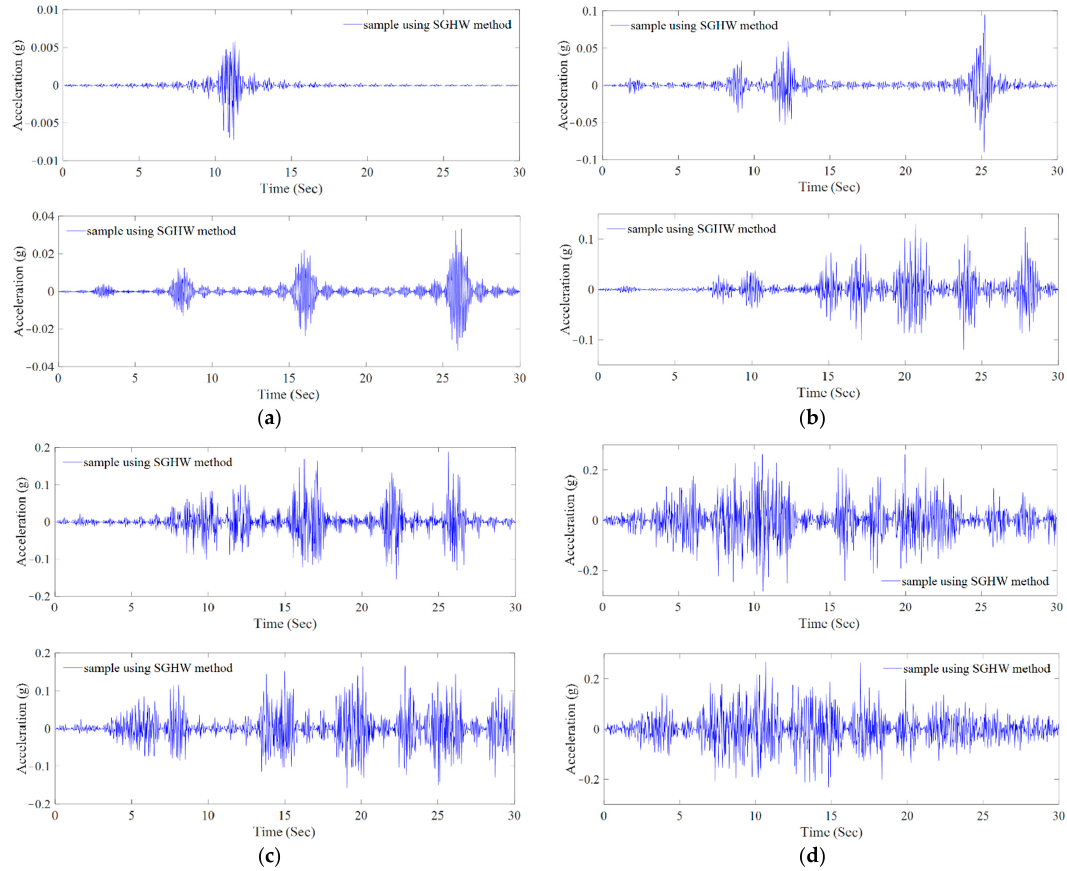
Figure 9. Typical samples by the SGHW method. ( a ) Ten components (upper: L = 5, D = 2; lower: L = 2, D = 5); ( b ) 50 components (upper: L = 10, D = 5; lower: L = 5, D = 10); ( c ) 150 components (upper: L = 15, D = 10; lower: L = 10, D = 15); ( d ) 500 components (upper: L = 25, D = 20; lower: L = 20, D = 25).